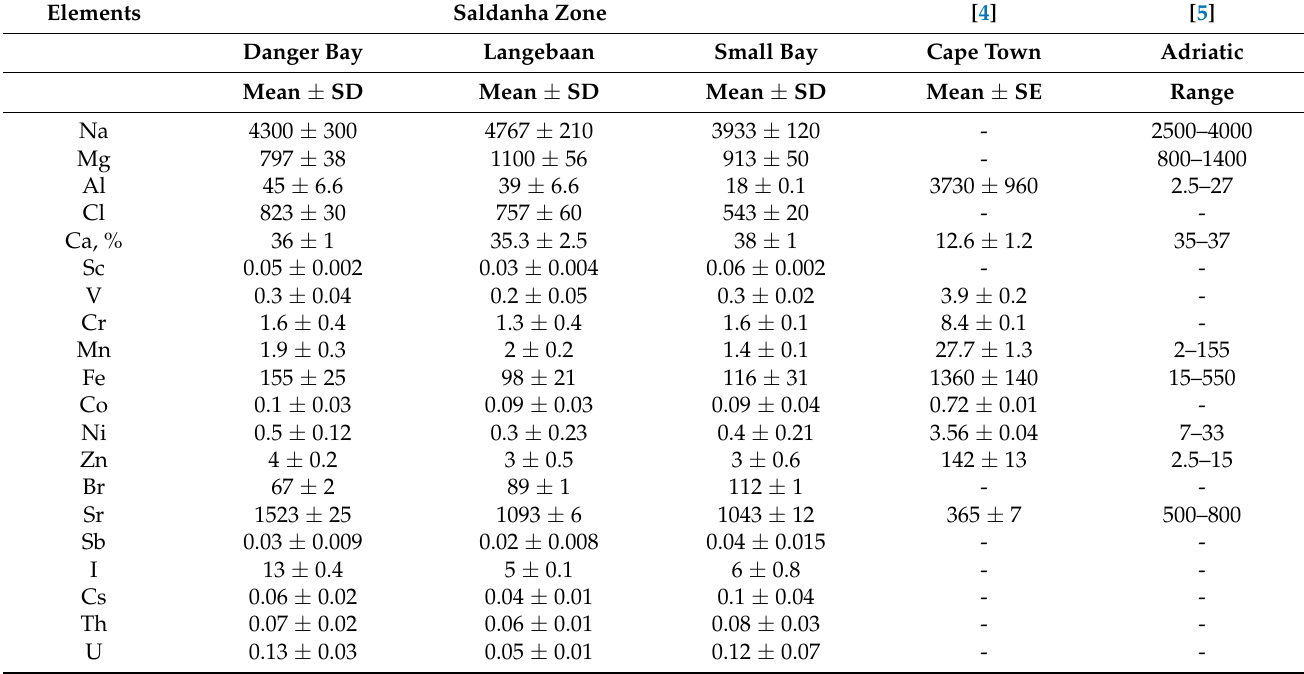
Table 3. Elements’ concentrations in shells of mussels (ppm, dry weight).